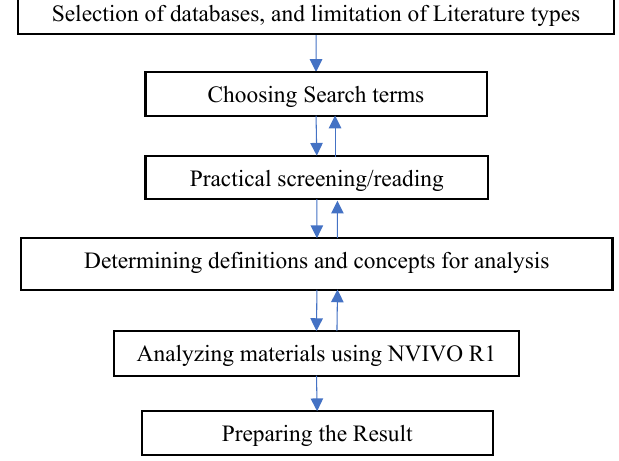
Fig. 1: The Literature Review Process (Fink, 2014)